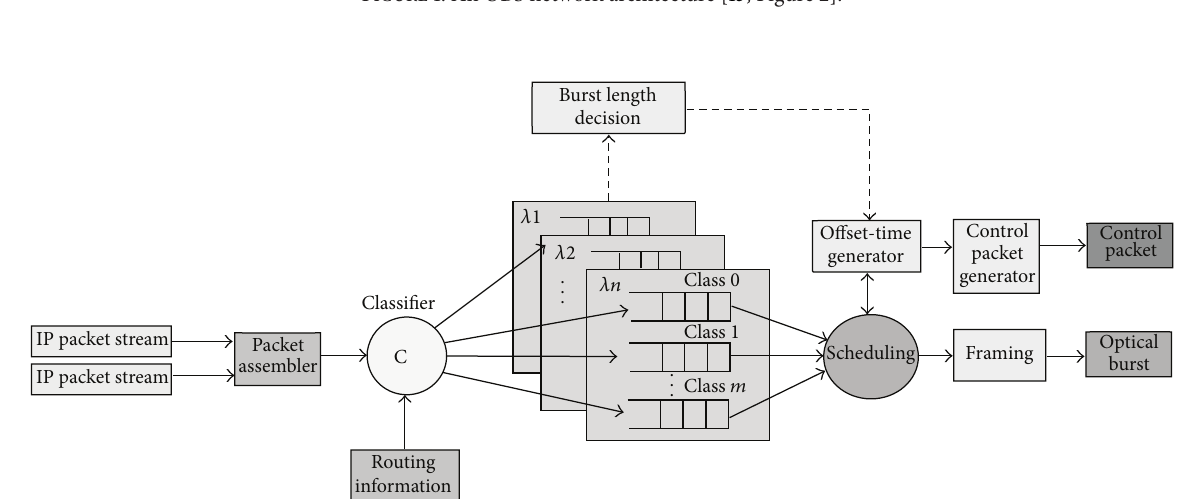
Figure 2: A functional model of an ingress node [15, Figure